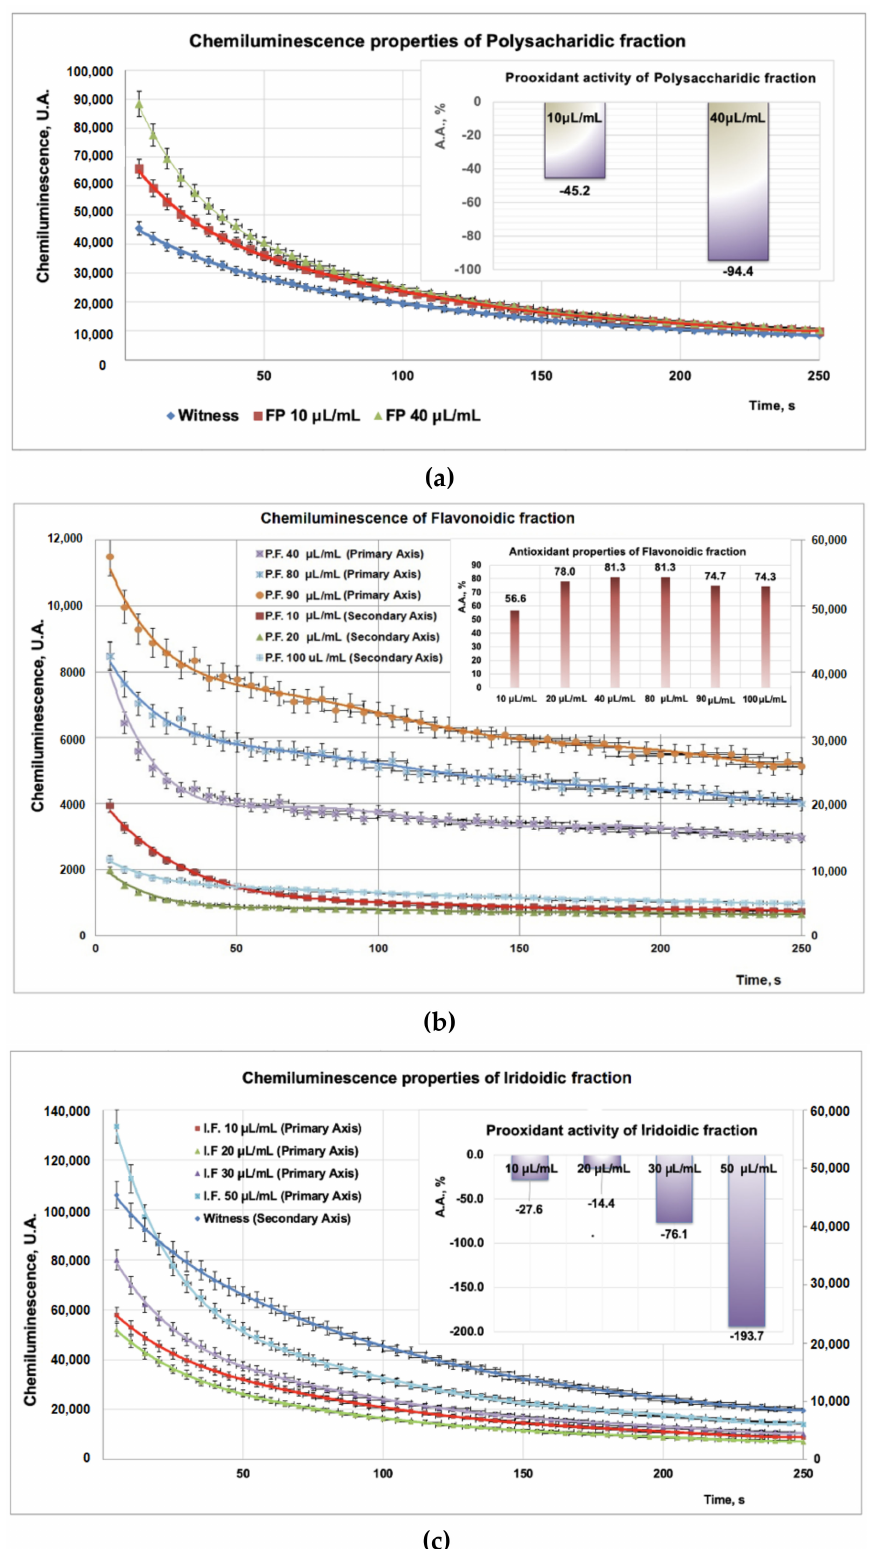
Figure 3. ( a ). Studies regarding chemiluminescence/prooxidant properties of PP fraction. ( b ) Studies regarding chemiluminescence/antioxidant properties of PF fraction (with the same witness as in ( a )). ( c ) Studies regarding chemiluminescence/prooxidant properties of PI